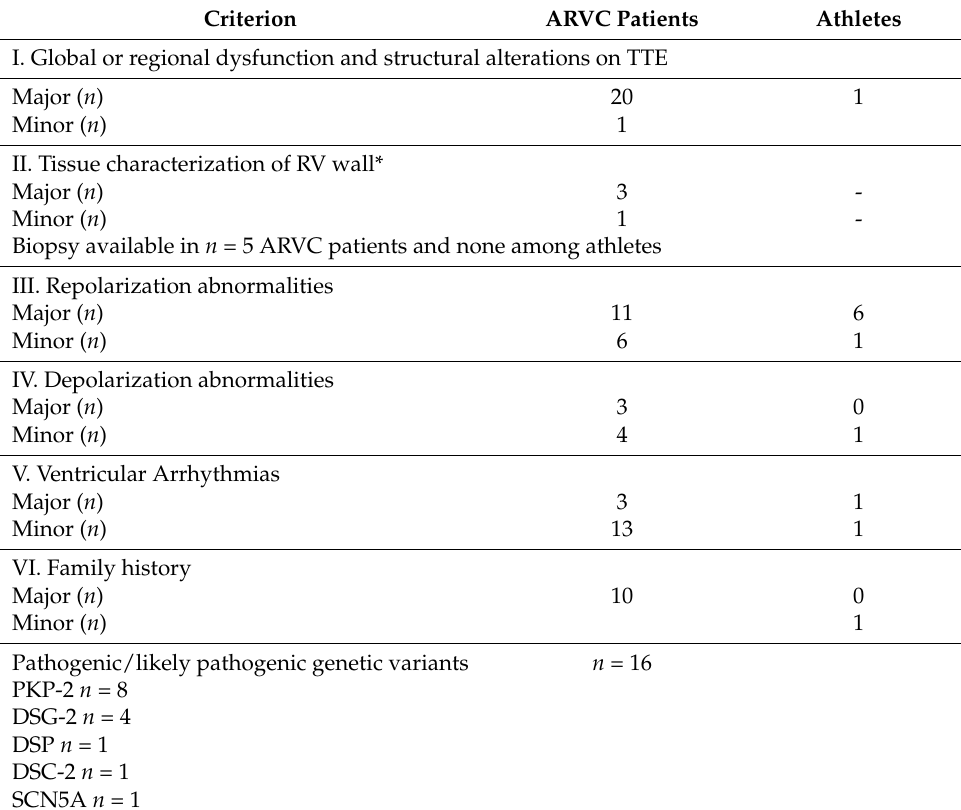
Table 3. 2010 TFC and genetic analyses in ARVC patients and